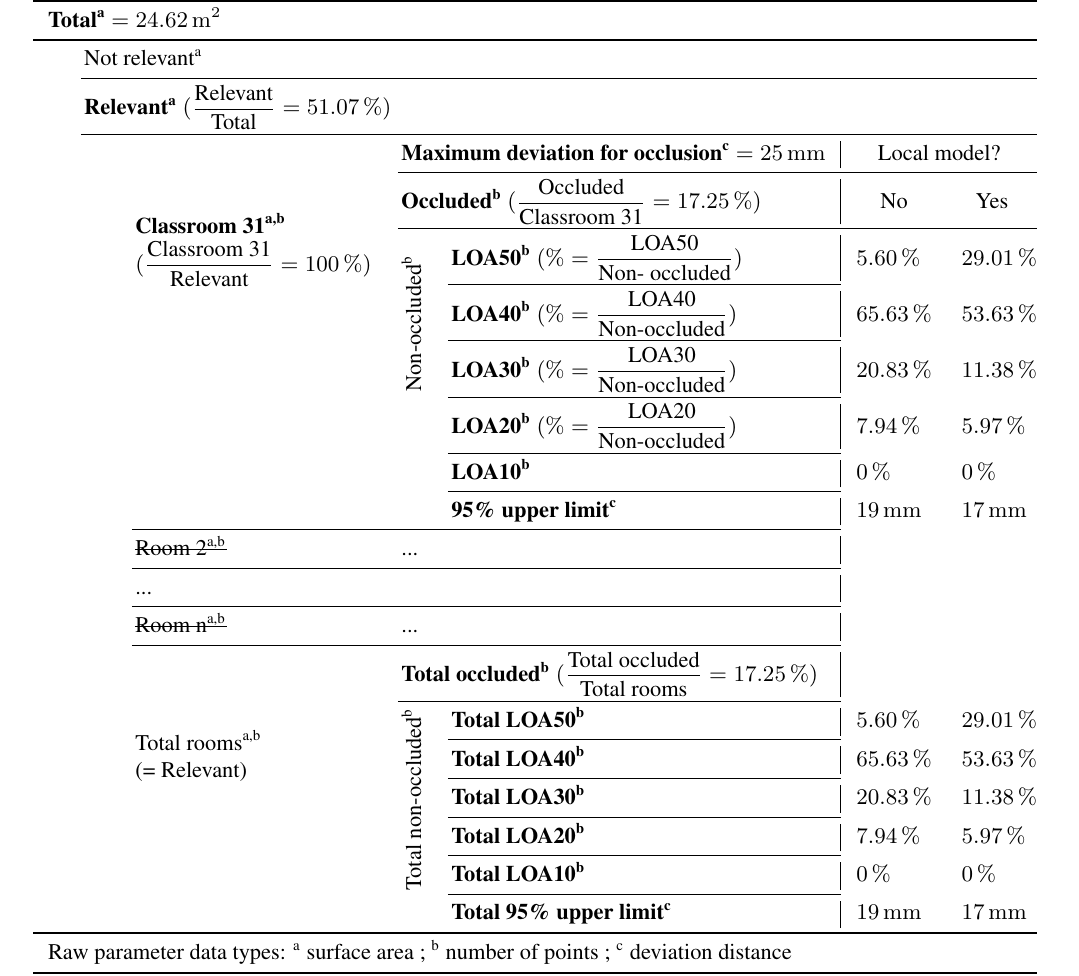
Table 4. Calculated quality assessment parameters of floor with ID 1191172. Parameters in bold are added to the BIM floor